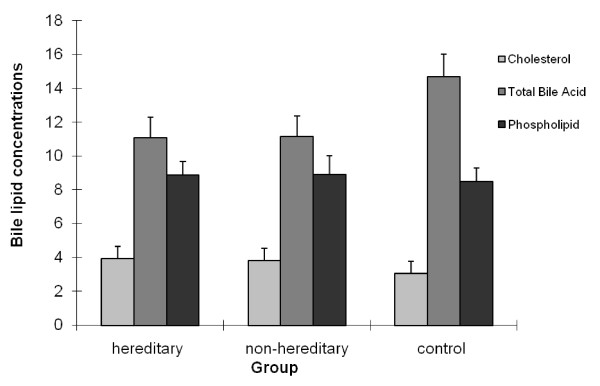
Changes of gallbladder bile Cholesterol, Total Bile Acids and Phospholipids in hereditary, non-hereditary cholesterol gallstone patients and control group. Bile cholesterol in hereditary, and non-hereditary cholesterol gallstone patients were both higher than that in control group, P < 0.05. But there was no significant difference in bile cholesterol level between hereditary and non-hereditary cholesterol gallstone patients. Three groups were compared by one way analysis of variance, F = 84.230, P < 0.05. Total bile acids level in hereditary and non-hereditary cholesterol gallstone patients were both lower than that in control group, P < 0.05. There was no significant difference in Total bile acids level between hereditary and non-hereditary cholesterol gallstone patients. Three groups were also analyzed by one way analysis of variance, F = 17.382, P < 0.05. There were no significant differences in Phospholipids level between three groups. Three groups were also compared by one way analysis of variance, F = 0.492, P > 0.05.